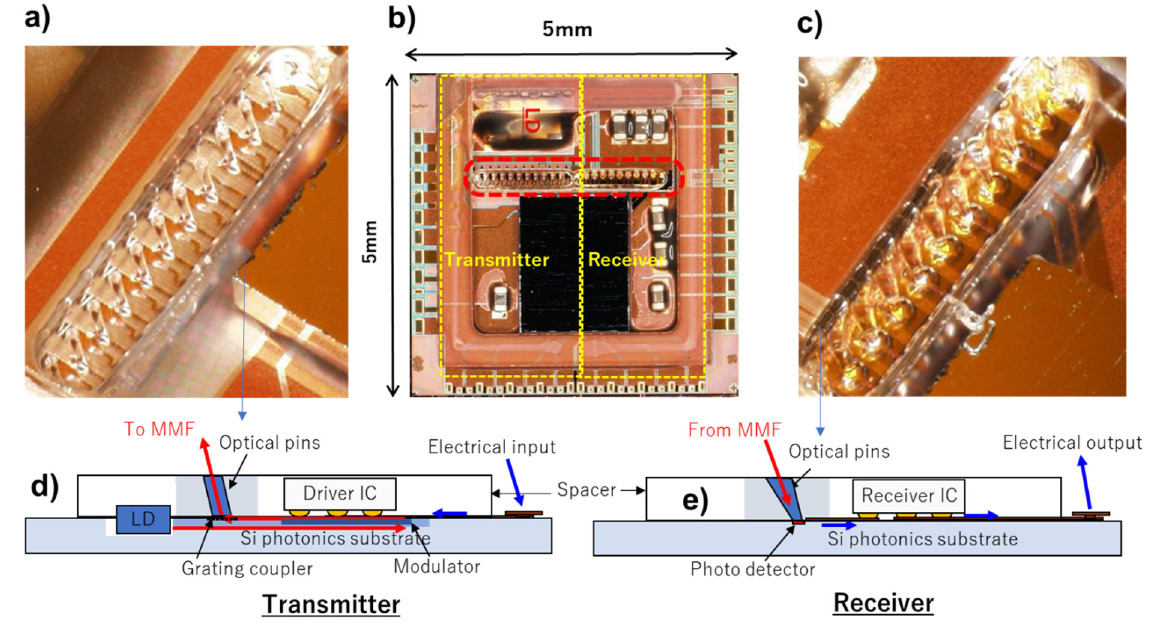
Figure 4. IOCore micro-transceiver: ( a ) photo of proprietary transmitter multimode optical interface [3]; ( b ) top photo of complete IOCore micro-transceiver; ( c ) photo of proprietary receiver multimode optical interface; ( d ) cross-section of transmitter section with untapered waveguides (“optical pins”); ( e ) cross-section of receiver section with tapered waveguides (“optical pins”) .